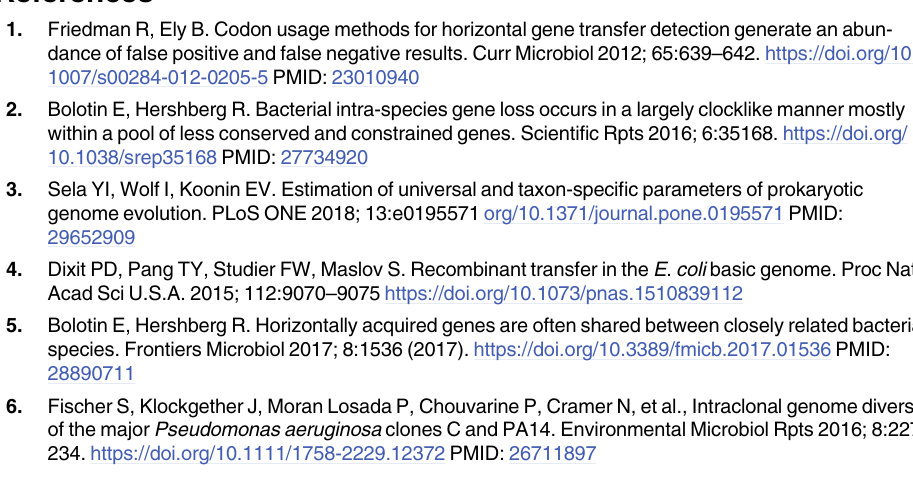
S2 Table. Evidence of site specific HGT in other